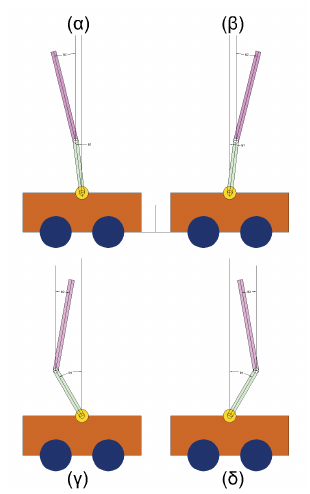
Figure 21. Set of Initial values.